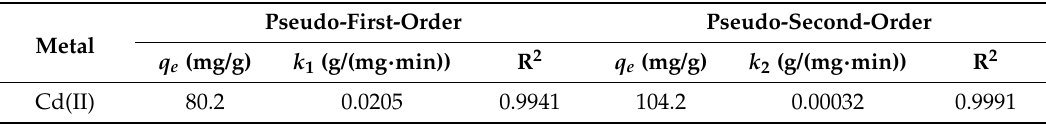
Table 1. Kinetic parameters of pseudo-first-order and pseudo-second-order kinetic model for Cd(II) adsorption on Mn oxide.